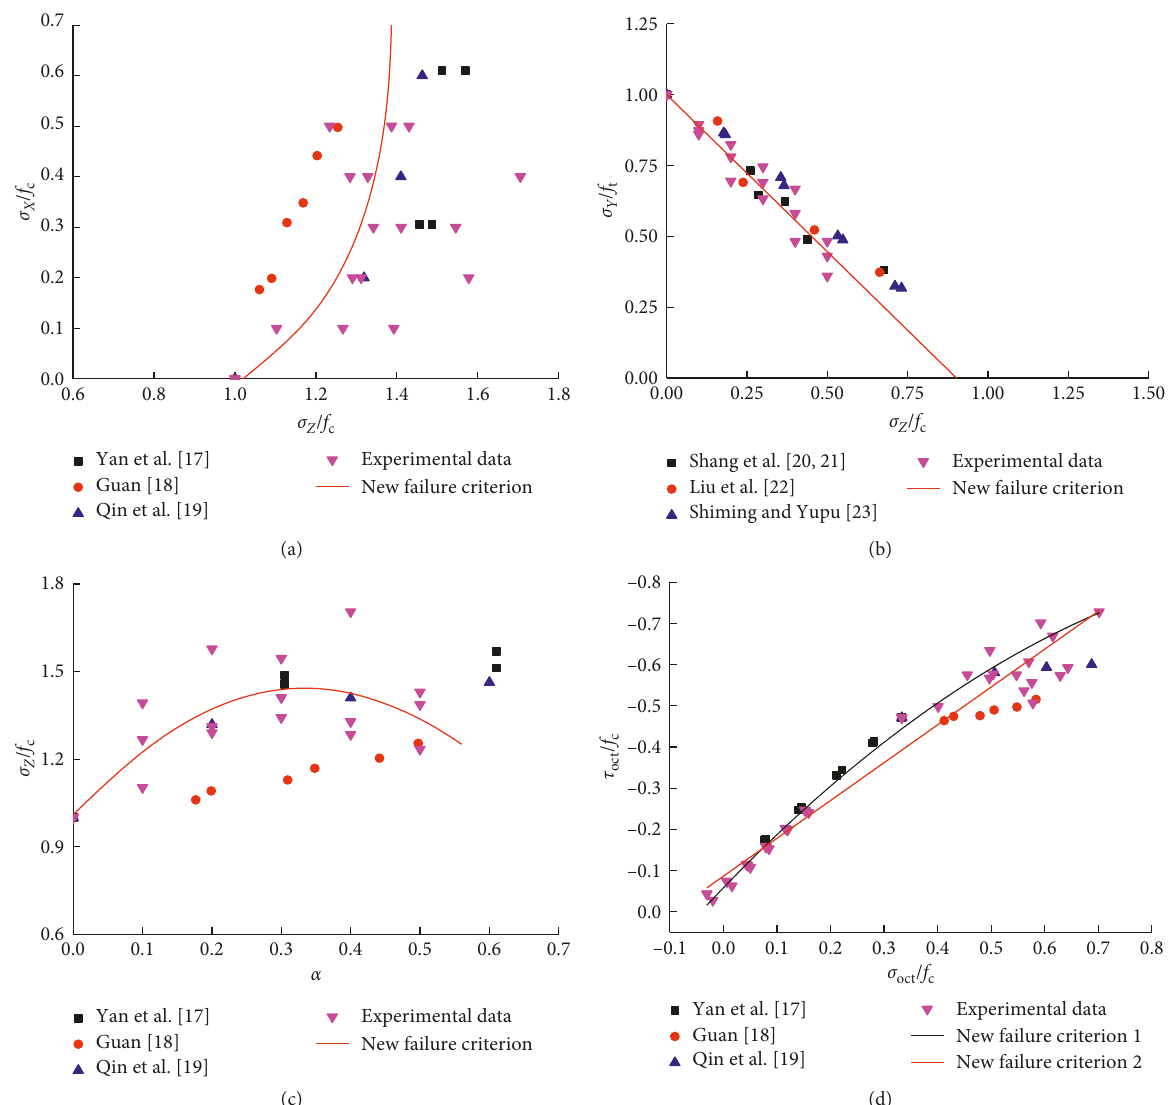
Figure 12: Verification of different failure criteria. The failure criterion of (a) biaxial compression-compression (based on Kupfer’s failure criterion); (b) biaxial tension-compression (based on Kupfer’s failure criterion); (c) biaxial compression-compression (based on unary quadratic equation); (d) octahedral stress